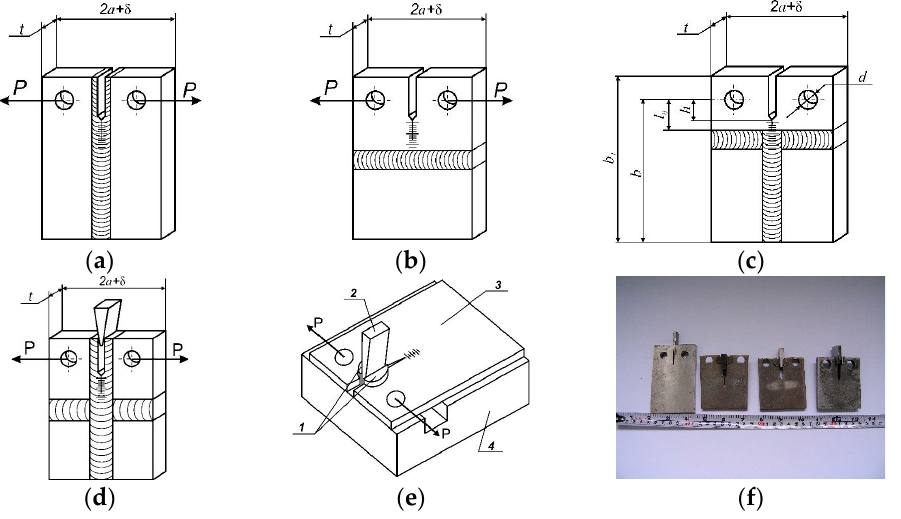
Figure 15. Samples for studying the parameters of the static crack resistance of welded joints of different configurations. Guide (longitude) ( a ), perpendicular ( b ), T-shaped ( c ), cruciform ( d ) (for investigation of cross-like WJ, which simulates real structures’ shell-bottom vessels under hydrogen pressure), wedge loading schemes ( d , e ) of prismatic-type compact specimens (P-force, t , 2 a + δ , b 1 —specimen thickness, width and length, d —hole diameter, h , l 0 , b —the distance from the hole center to the concentrator tip, the end of the initiated fatigue crack and the finish of the crack path) [36–40]: 1—guide plates, 2—wedge, 3—specimen, 4—guide plate (loaded with a wedge of two types of fixation) after specimens’ long-term exposure in gaseous hydrogen with high pressures and temperatures ( f ) [35–40].